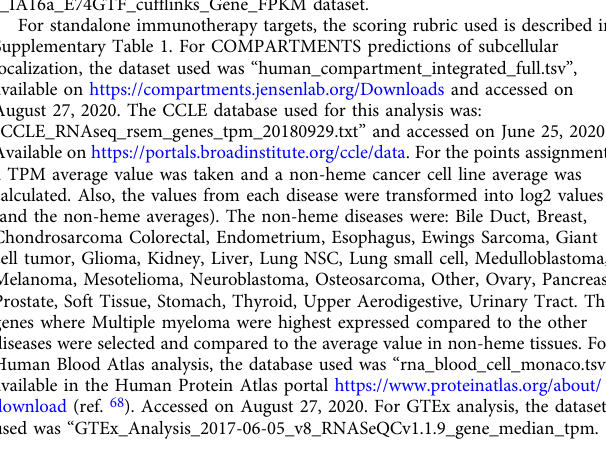
Supplementary Table 1. For COMPARTMENTS predictions of subcellular localization, the dataset used was “ human_compartment_integrated_full.tsv ” , available on https://compartments.jensenlab.org/Downloads and accessed on August 27, 2020. The CCLE database used for this analysis was: “ CCLE_RNAseq_rsem_genes_tpm_20180929.txt ” and accessed on June 25, 2020. Available on https://portals.broadinstitute.org/ccle/data. For the points